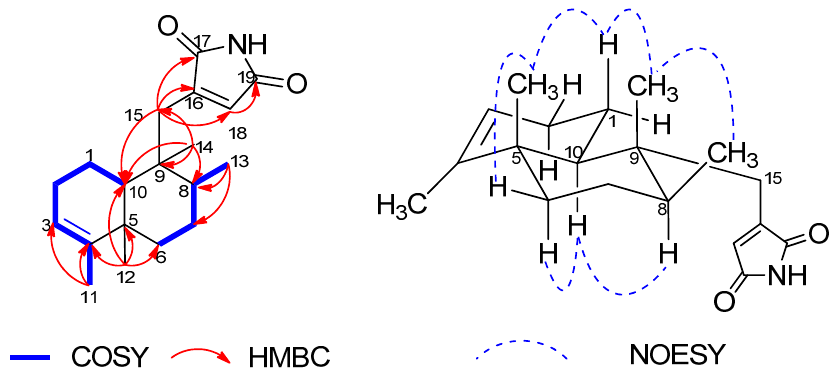
Figure 2. Key COSY, HMBC, and NOESY correlations of dysidinoid A ( 1